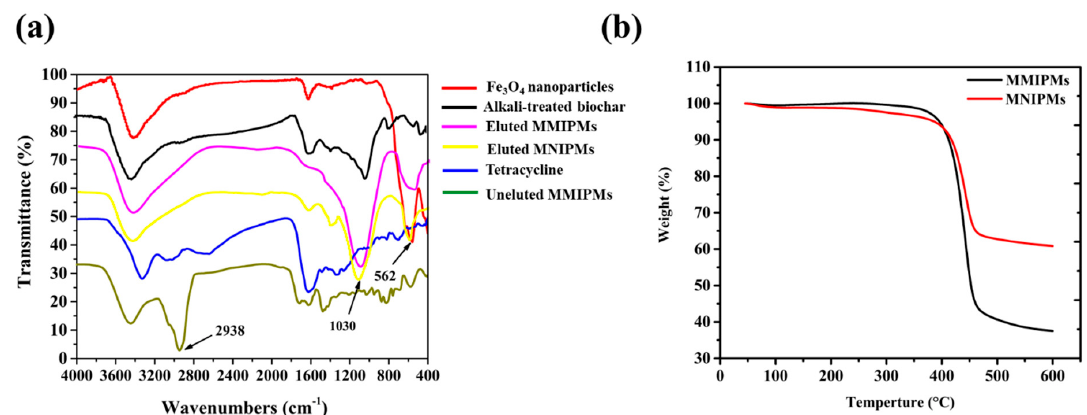
Figure 5. FT-IR spectrum of different materials ( a ), thermogravimetry (TGA) analysis of MMIPMs and MNIPMs ( b ).